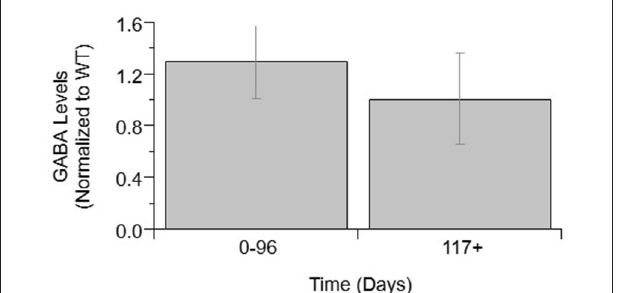
FIGURE 2 | GABA levels over ALS disease progression. GABA level average normalized to wild-type (ratio presented as transgenic/WT) in two temporal stages: 0–96 days and 117 + days. Error bars represent